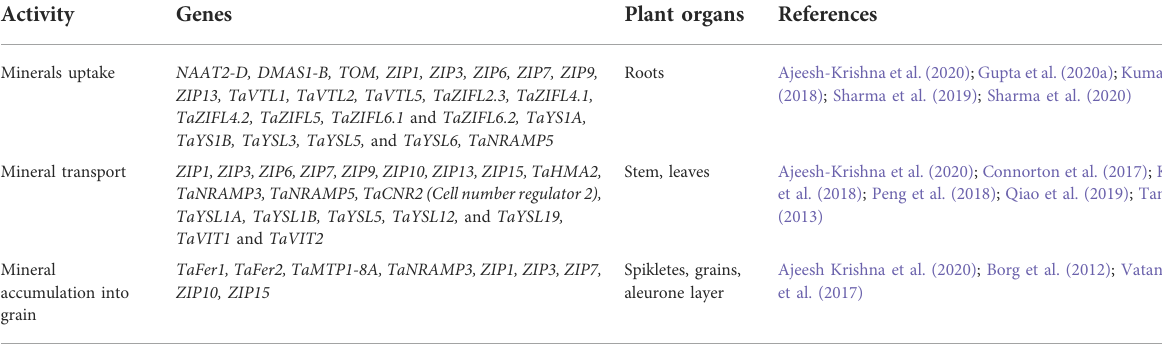
TABLE 1 Summary of genes involved in uptake, transport and grain accumulation of Zn and Fe in wheat.